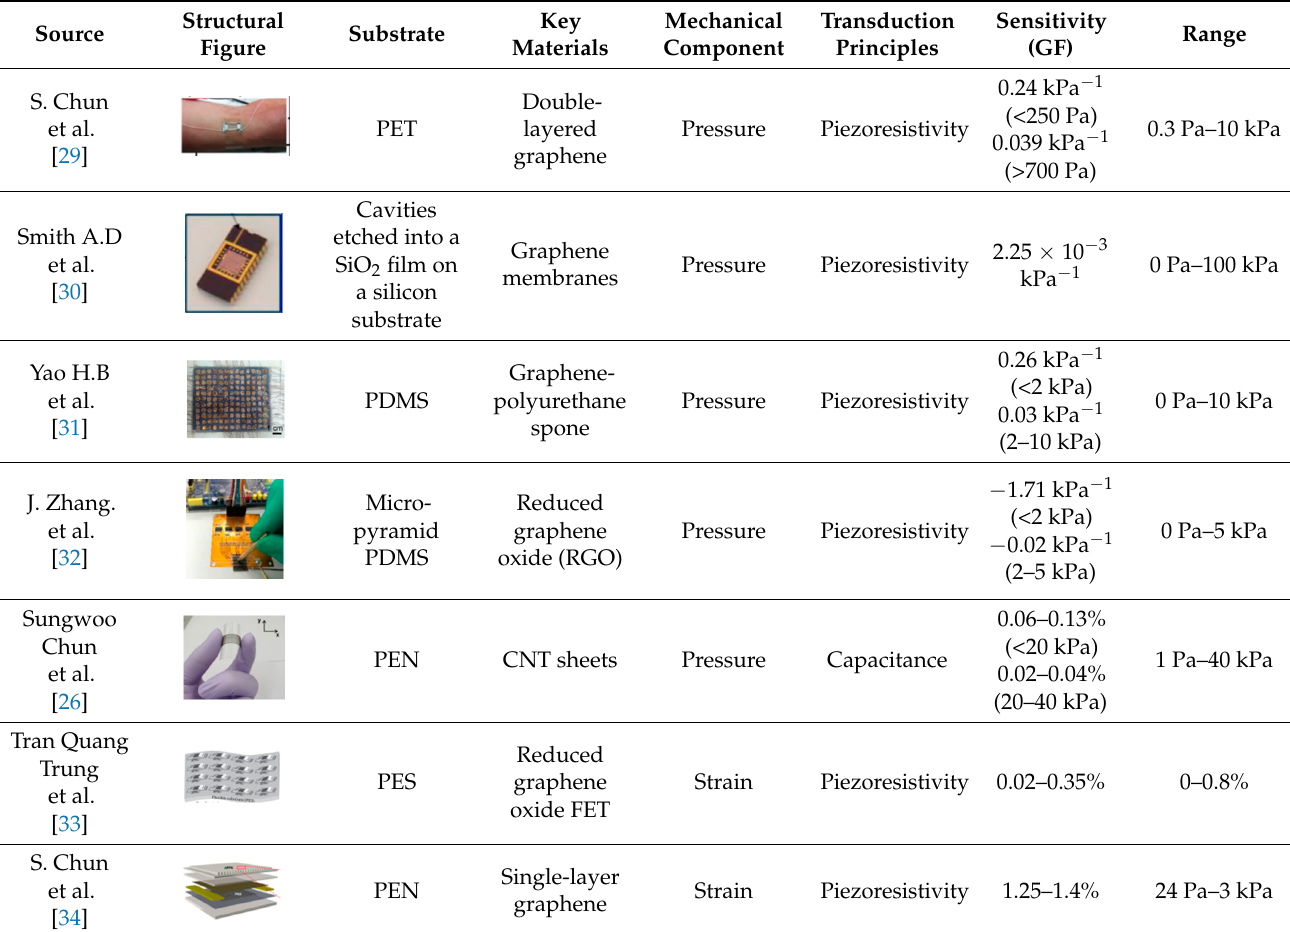
Table 1. Summary of some flexible sensors and relevant performance parameters. Substrate Figure